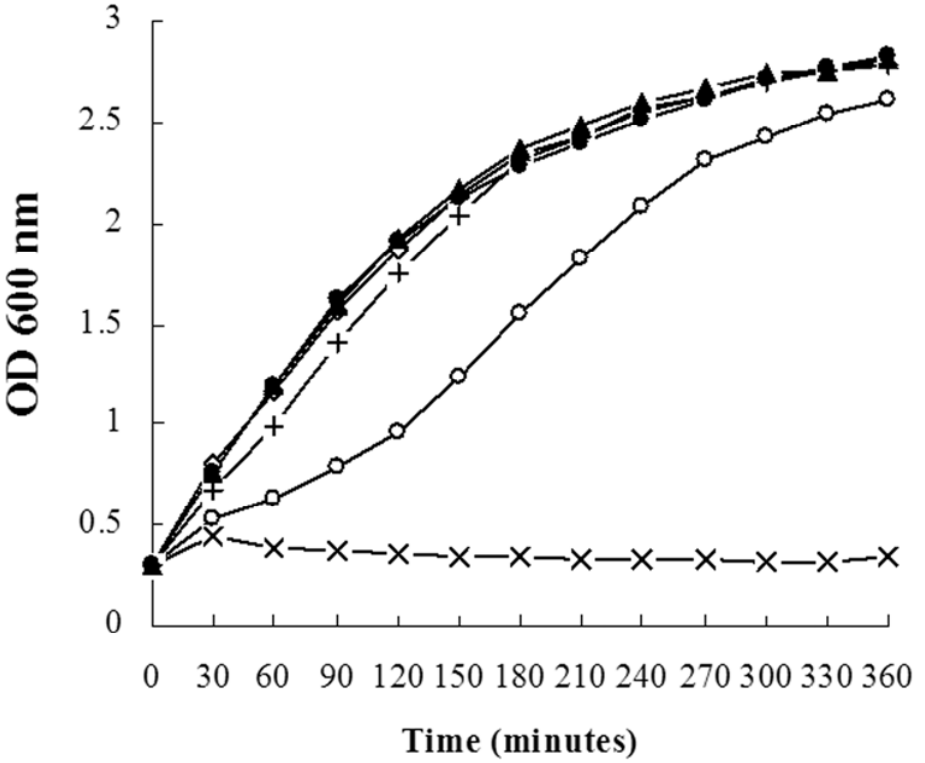
Figure 1. Growth curves for S. aureus ATCC 29213 cultured in MHB with different concentrations of peppermint oil. ( ) represents ◇ untreated S. aureus ; ( ● ) represents S. aureus cultured with 8 µg/mL peppermint oil; ( ▲ ) represents S. aureus cultured with 16 µg/mL peppermint oil; (+) represents S. aureus cultured with 32 µg/mL peppermint oil; ( ○ ) represents S. aureus cultured with 64 µg/mL peppermint oil; and (×) represents S. aureus cultured with 128 µg/mL peppermint